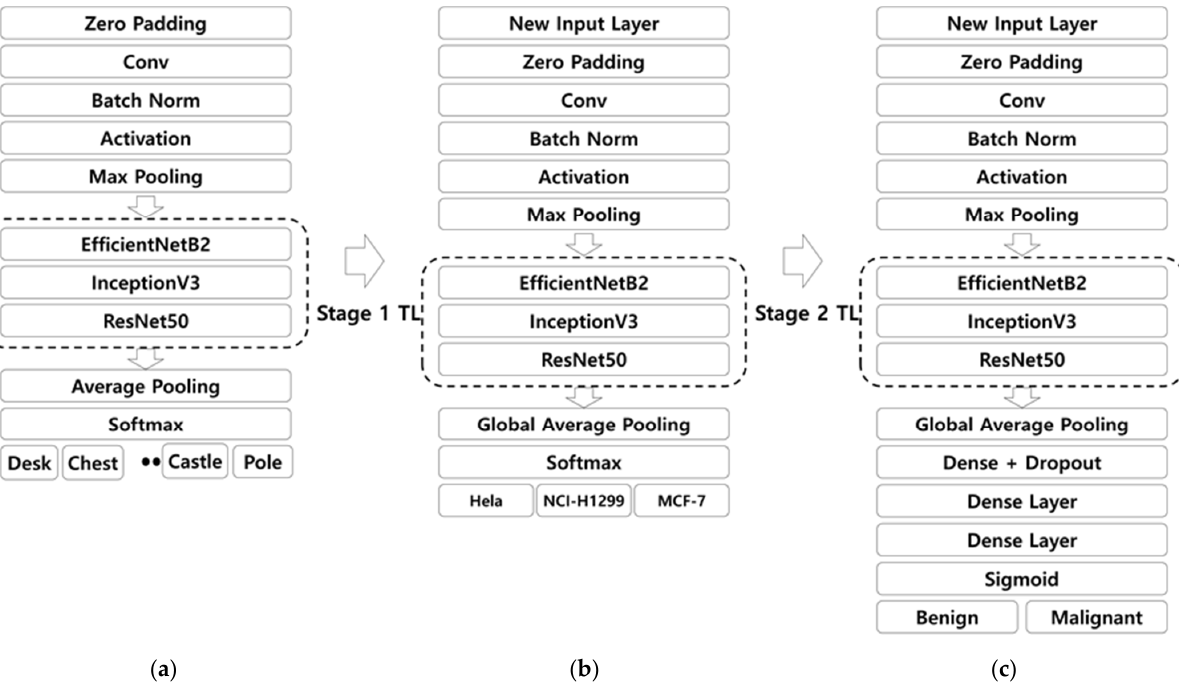
Figure 3. CNN models at each stage of transfer learning. ( a ) Original ImageNet pre ‐ trained model. ( b ) ImageNet pre ‐ trained model that is transfer ‐ learned to cell line images. ( c ) ImageNet followed by cell line images pre ‐ trained model that is transfer ‐ learned to ultrasound images. Conv: Convolution; TL: Transfer Learning; Norm: Normalization.